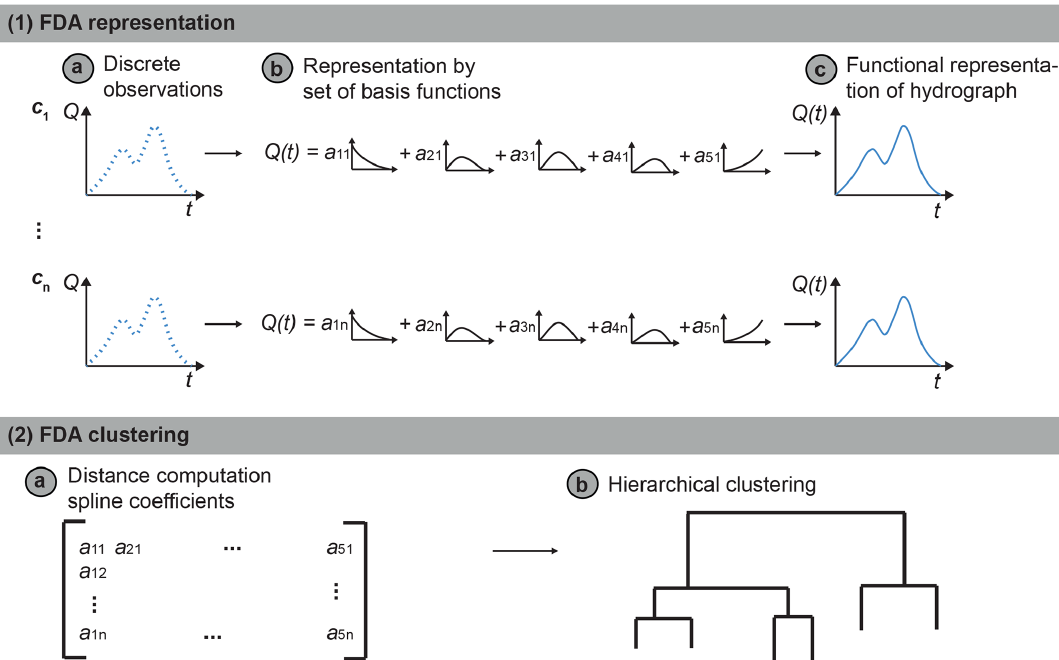
Figure 1. Functional data (FDA) clustering procedure: (1) FDA representation of regimes by projecting (a) discrete observations to (b) a set of spline bases to derive a (c) functional representation of the hydrological regimes. (2) FDA clustering by computing (a) a distance matrix using the spline coefficients from Step 1 in a (b) hierarchical clustering